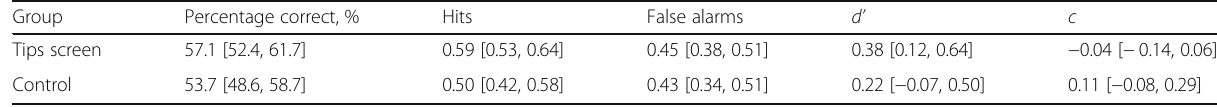
Table 1 A summary of the data for Experiment 2 Group Percentage correct,